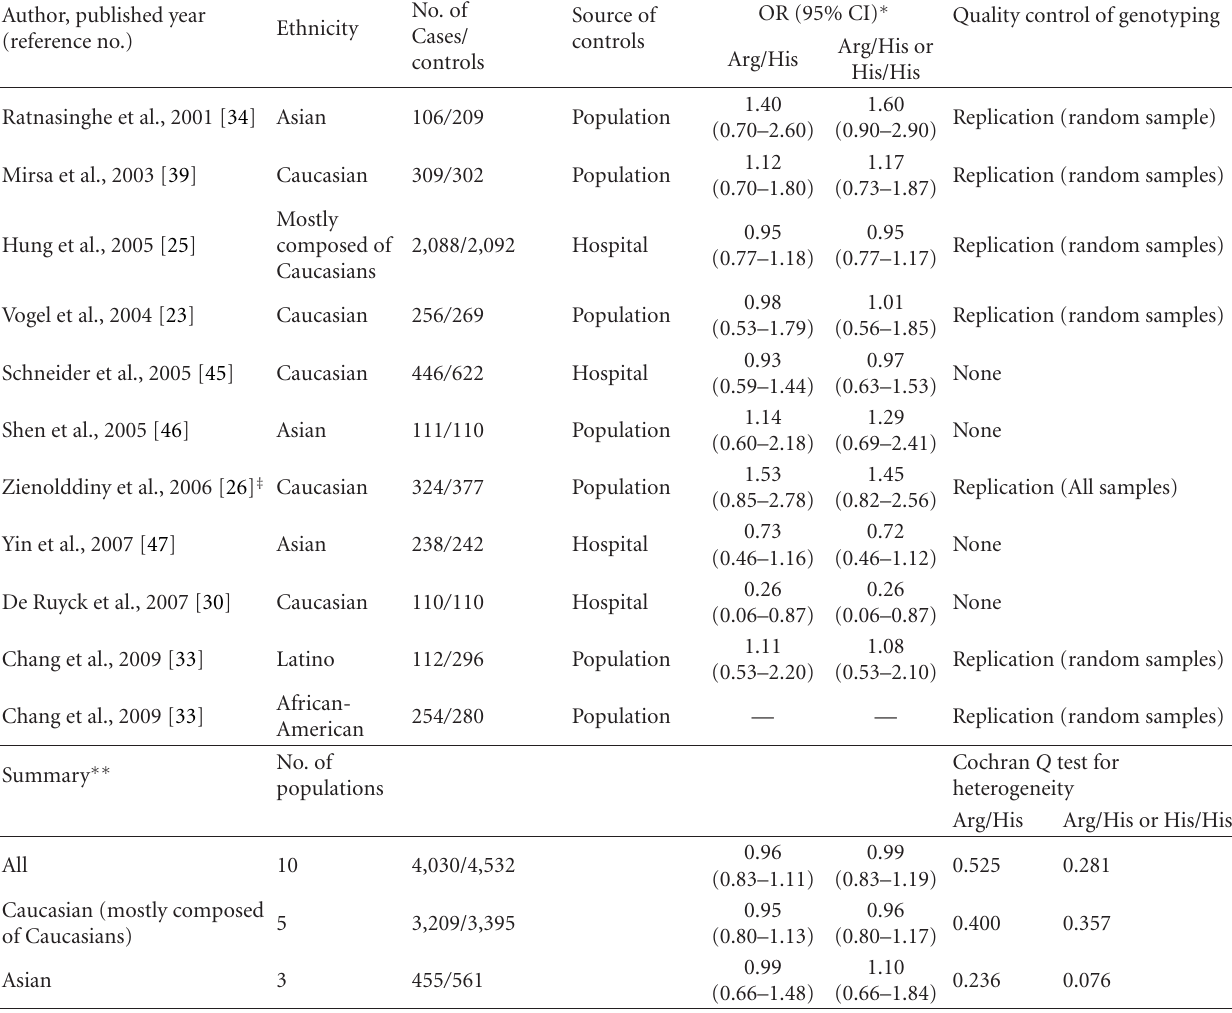
Table 5: Genetic polymorphisms in the BER pathway and lung cancer risk: XRCC1 Arg280His